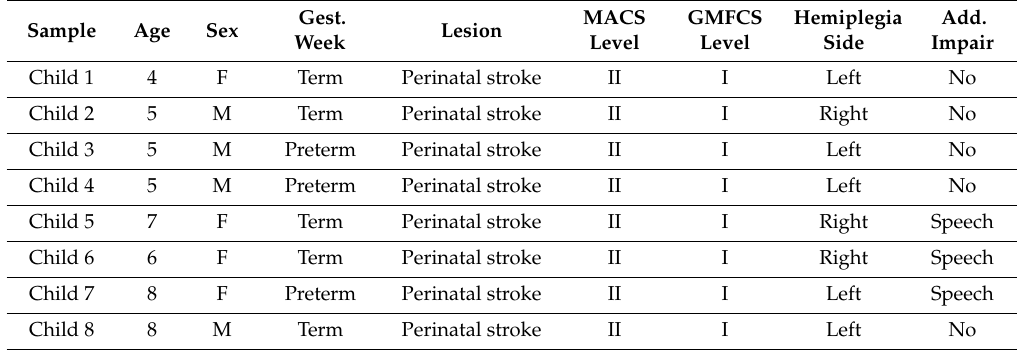
Table 3. Baseline characteristics of the participants.